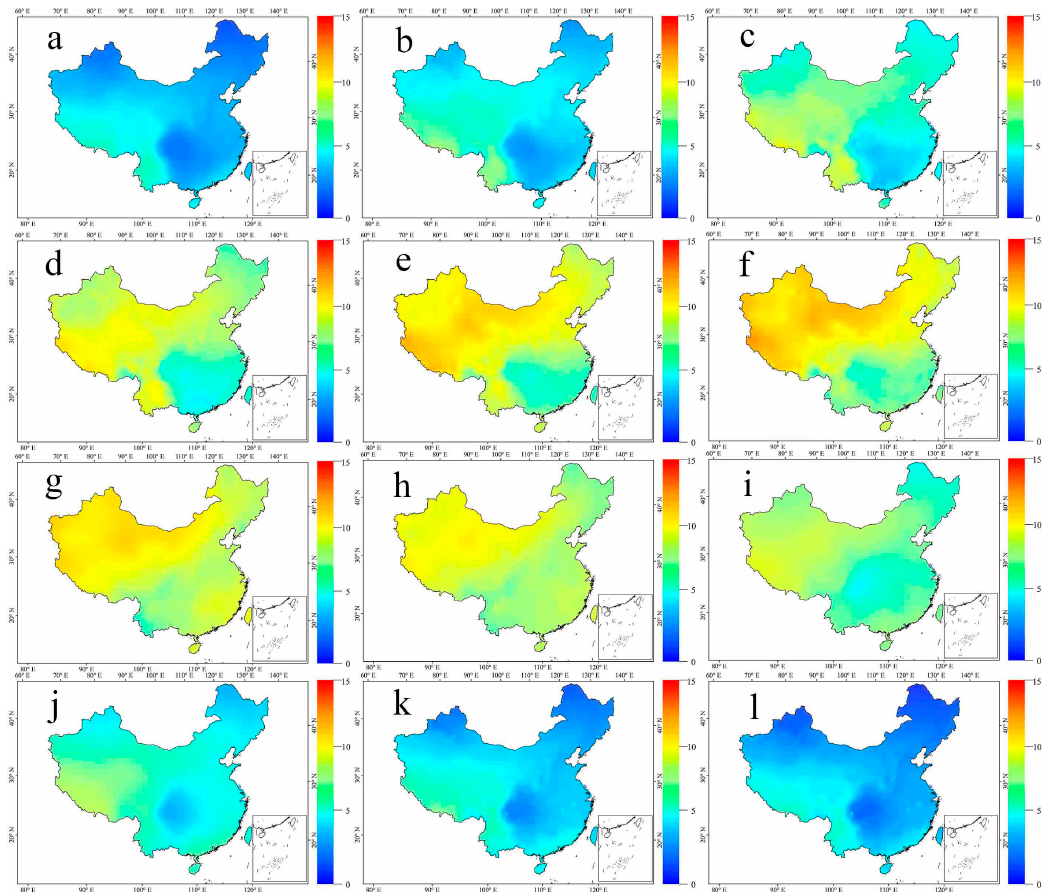
Figure 12. Spatial and temporal variations of PAR (MJ m − 2 day − 1 ) over mainland China; ( a ) January, ( b ) February, ( c ) March, ( d ) April, ( e ) May, ( f ) June, ( g ) July, ( h ) August, ( i ) September, ( j ) October, ( k ) November, and ( l ) December.